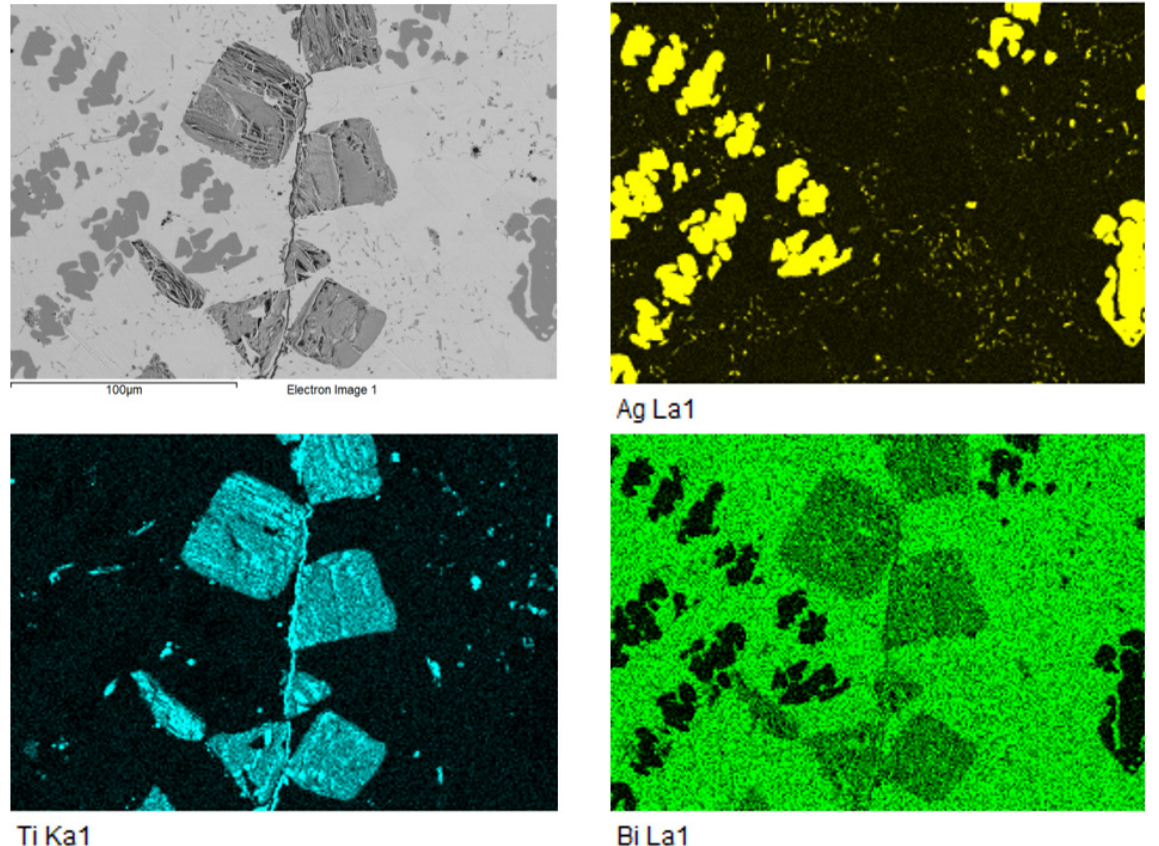
Figure 10. Map of Ag, Ti, and Bi elements in microstructure of Bi11Ag1.5Ti solder.